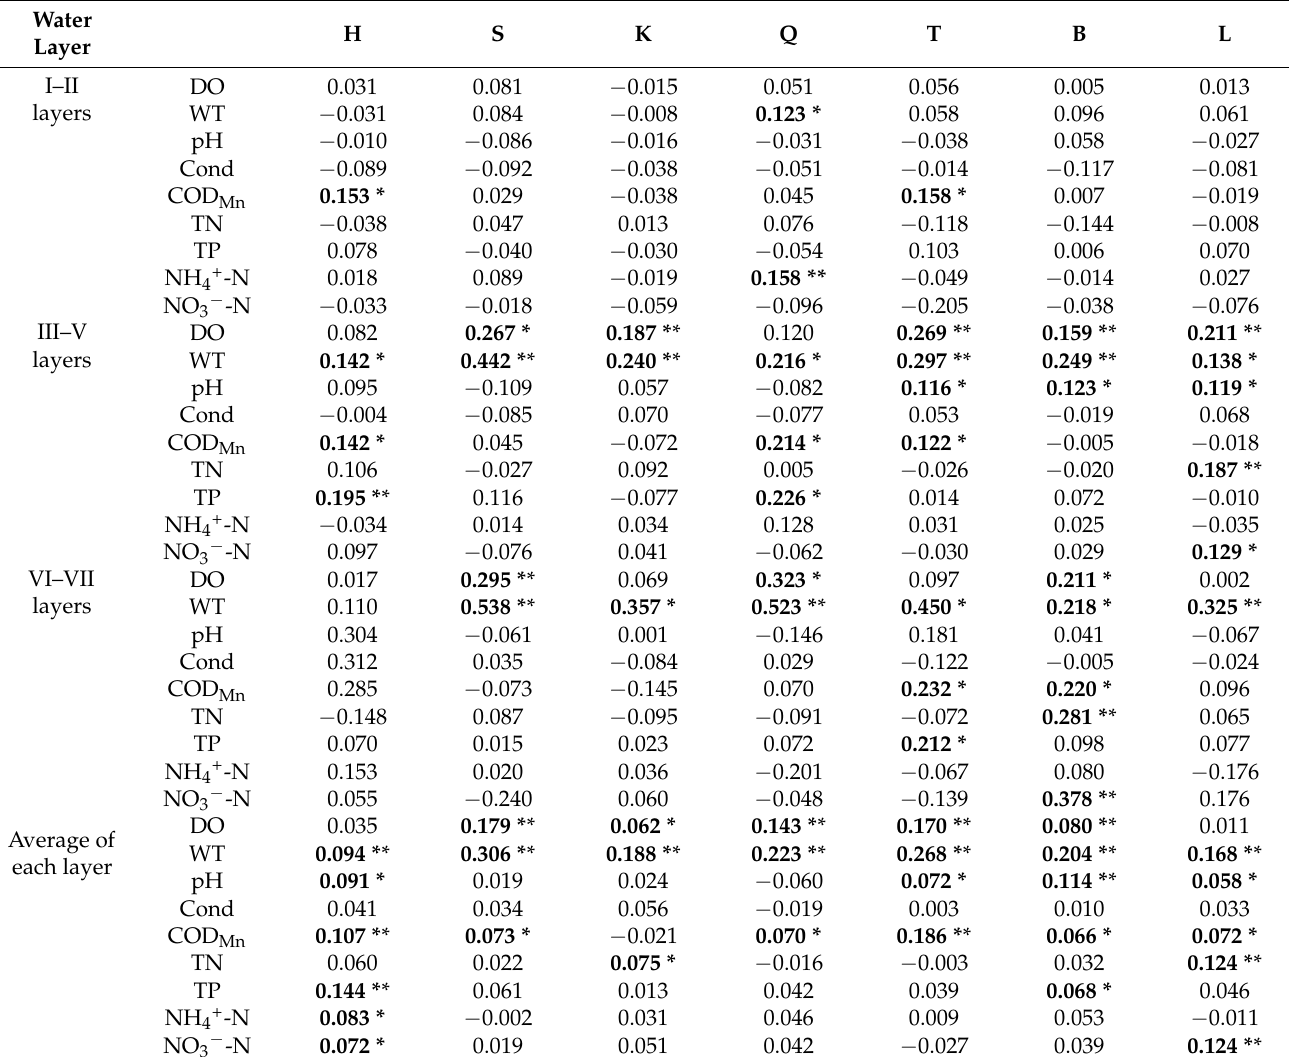
Table 4. Mantel test of phytoplankton community and physical and chemical factors in different water layers in the Danjiangkou